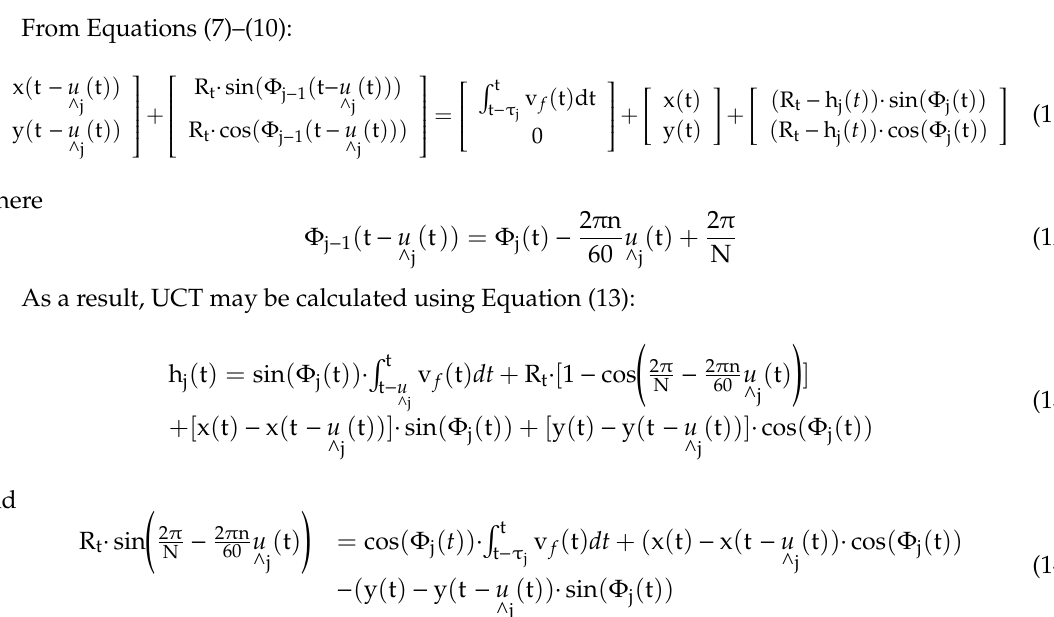
Figure 4. Model of undeformed chip thickness